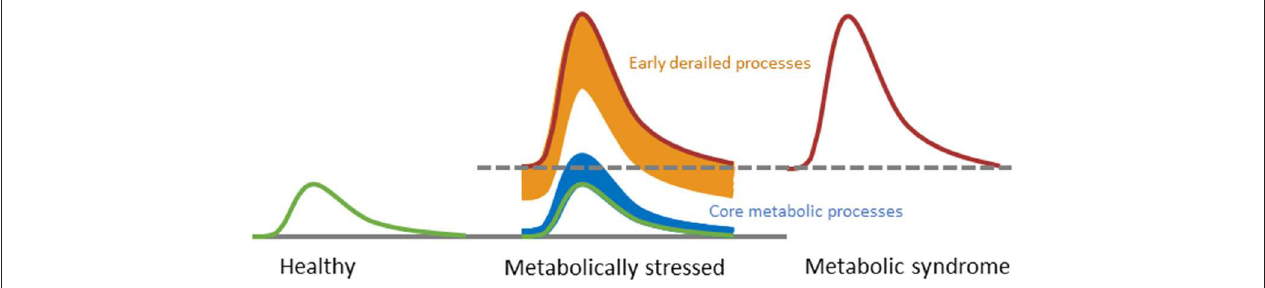
FIGURE 5 | Conceptual representation of challenge tests may evaluate the progression toward metabolic disorder. During progression from a healthy state toward a state of metabolic syndrome, only the early derailed processes respond differently to a challenge test in order to keep the core processes in balance. Eventually, the balance of the core processes is also disrupted. Modified with permission from Kardinaal et al.